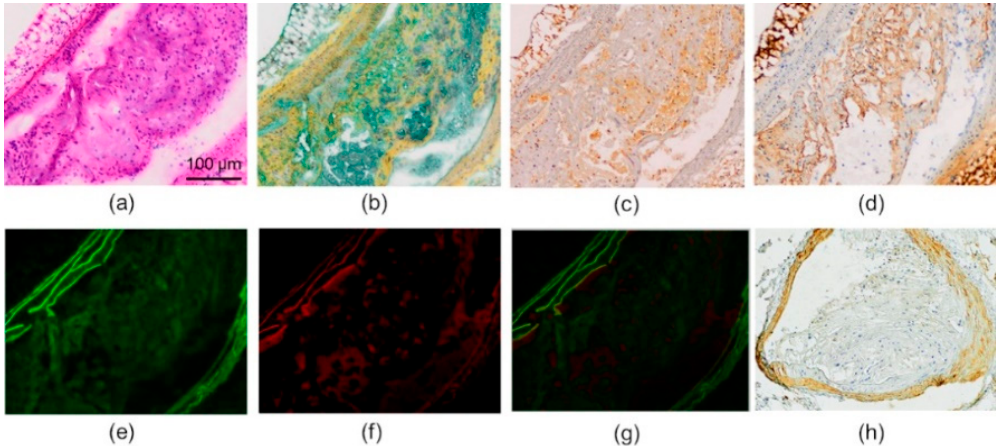
Figure 4. Histology of the mouse atherosclerotic plaques. ( a ) Hematoxylin and eosin staining shows cell-rich plaque in the brachiocephalic artery. ( b ) Movat’s pentachrome staining shows fibrotic tissue as yellow and lipids as green. ( c ) Mac-3 immunostaining of the plaque shows abundant infiltration of macrophages. ( d ) Ox-LDL immunostaining. ( e ) Fluorescent thioflavin-S amyloid staining. ( f ) The same section as in E imaged after the fading of thioflavin-S fluorescence shows the areas of autofluorescence. ( g ) A merged image of E and F localizes the autofluorescence to mainly the media and areas with only low thioflavin-S fluorescence. ( h ) Amyloid beta immunostaining of another brachiocephalic plaque shows intense staining in vessel wall, but only minimal staining in the plaque intima.